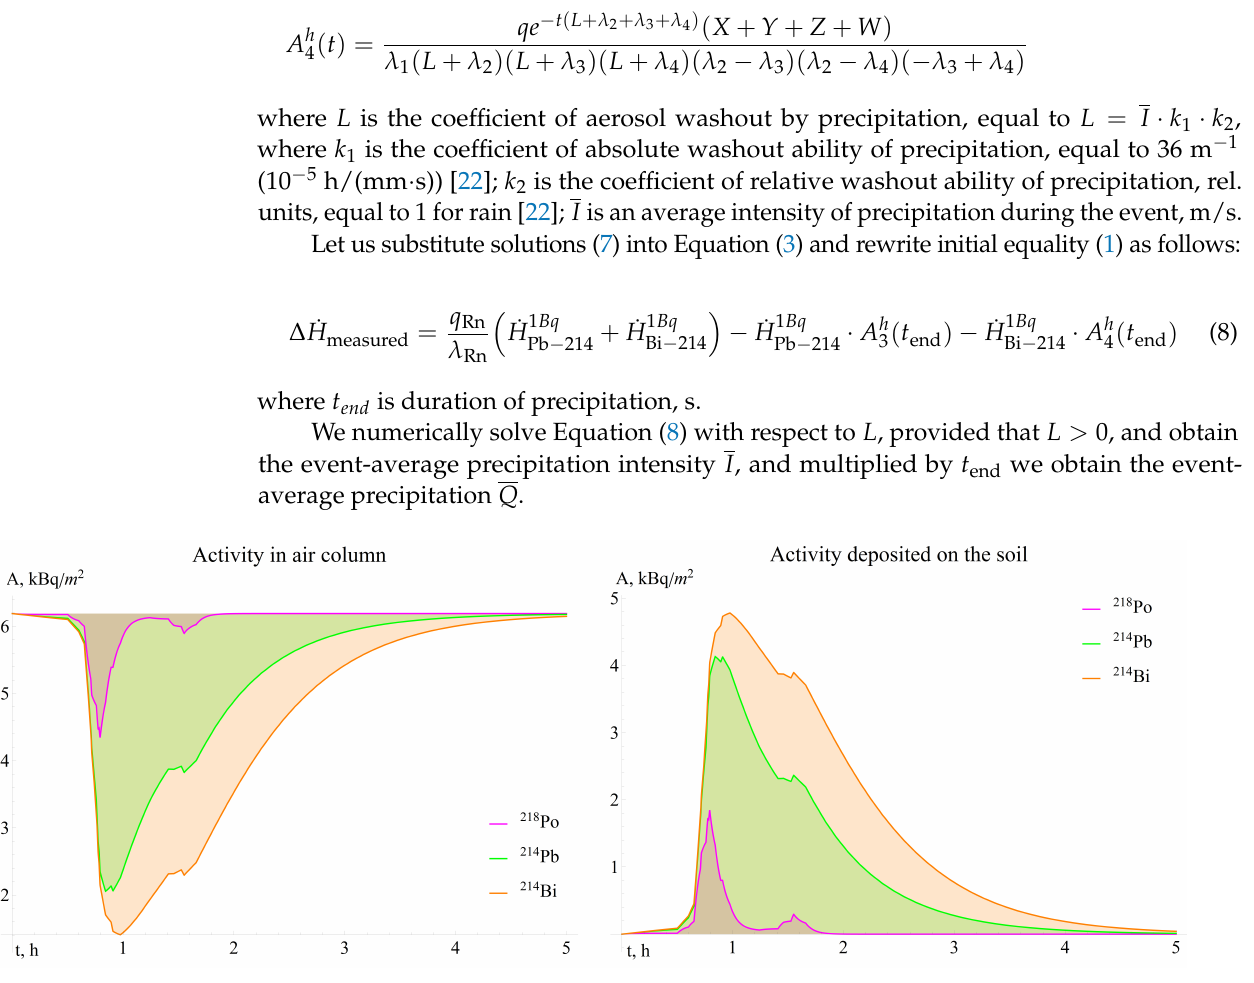
Figure 4. Dynamics of radon daughter decay products activity in the atmosphere and on the soil surface during the precipitation period on 11 June